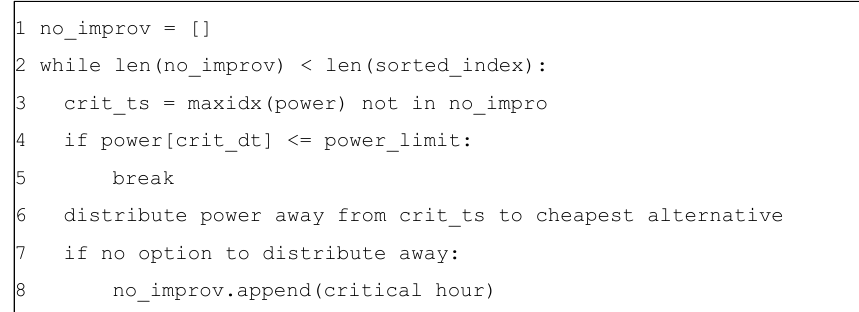
Figure A1. Price-optimisation pseudo code. Figure A1 . Price-optimisation pseudo code Figure A1 . Price-optimisation pseudo code